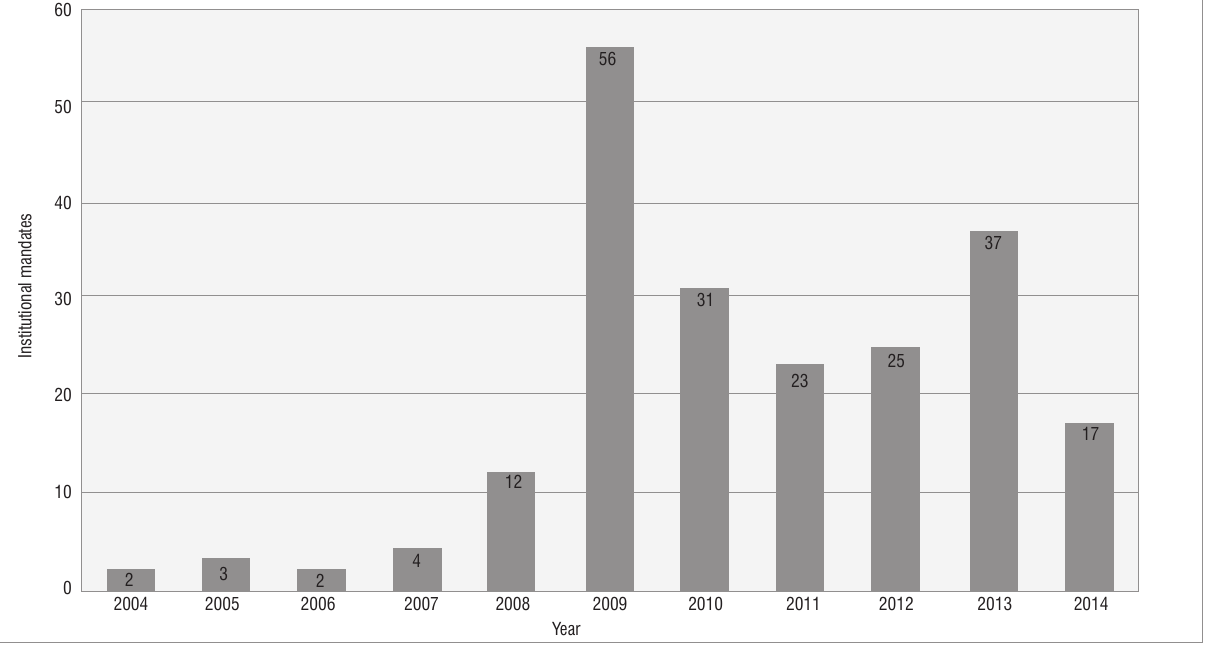
Figure 5: The number of institutional mandates on open-access publishing per year recorded in the Registry of Open Access Repositories Mandatory Archiving Policies (ROARMAP) 12